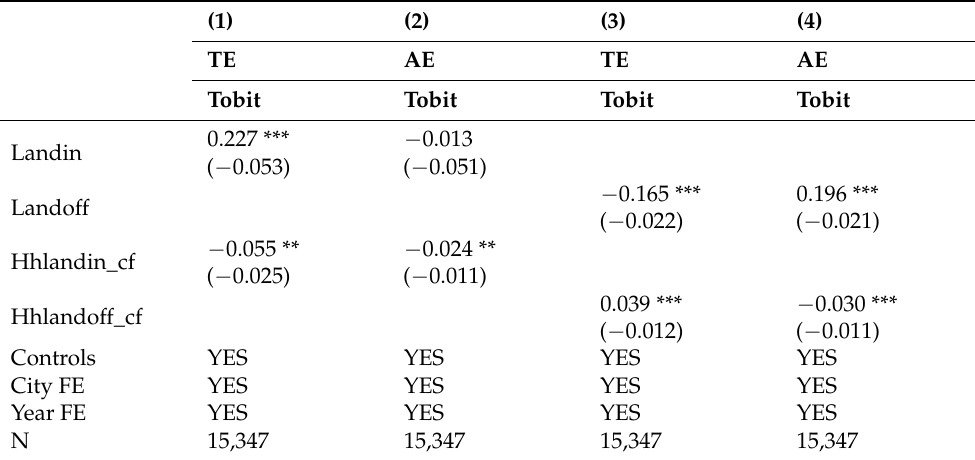
Table 5. Land transfer and rural household efficiency: control function